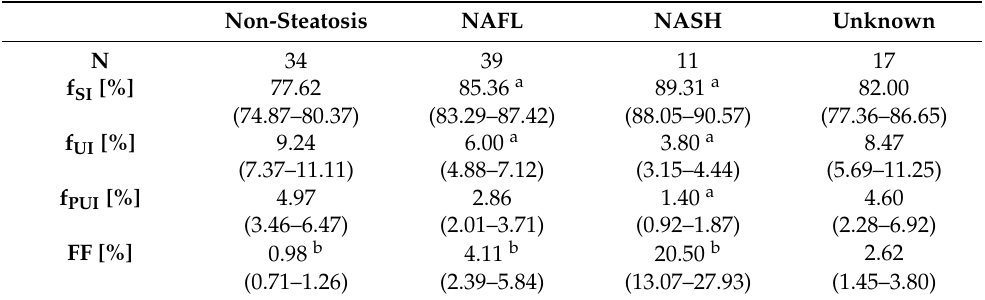
Table 3. Fractions of hydrogen atoms in saturated (f SI ), unsaturated (f UI ) and polyunsaturated (f PUI ) functional groups of FA chains in Tx subgroups. Fractions are categorized based on histological results (95% confidence intervals are given in parentheses; N—number of